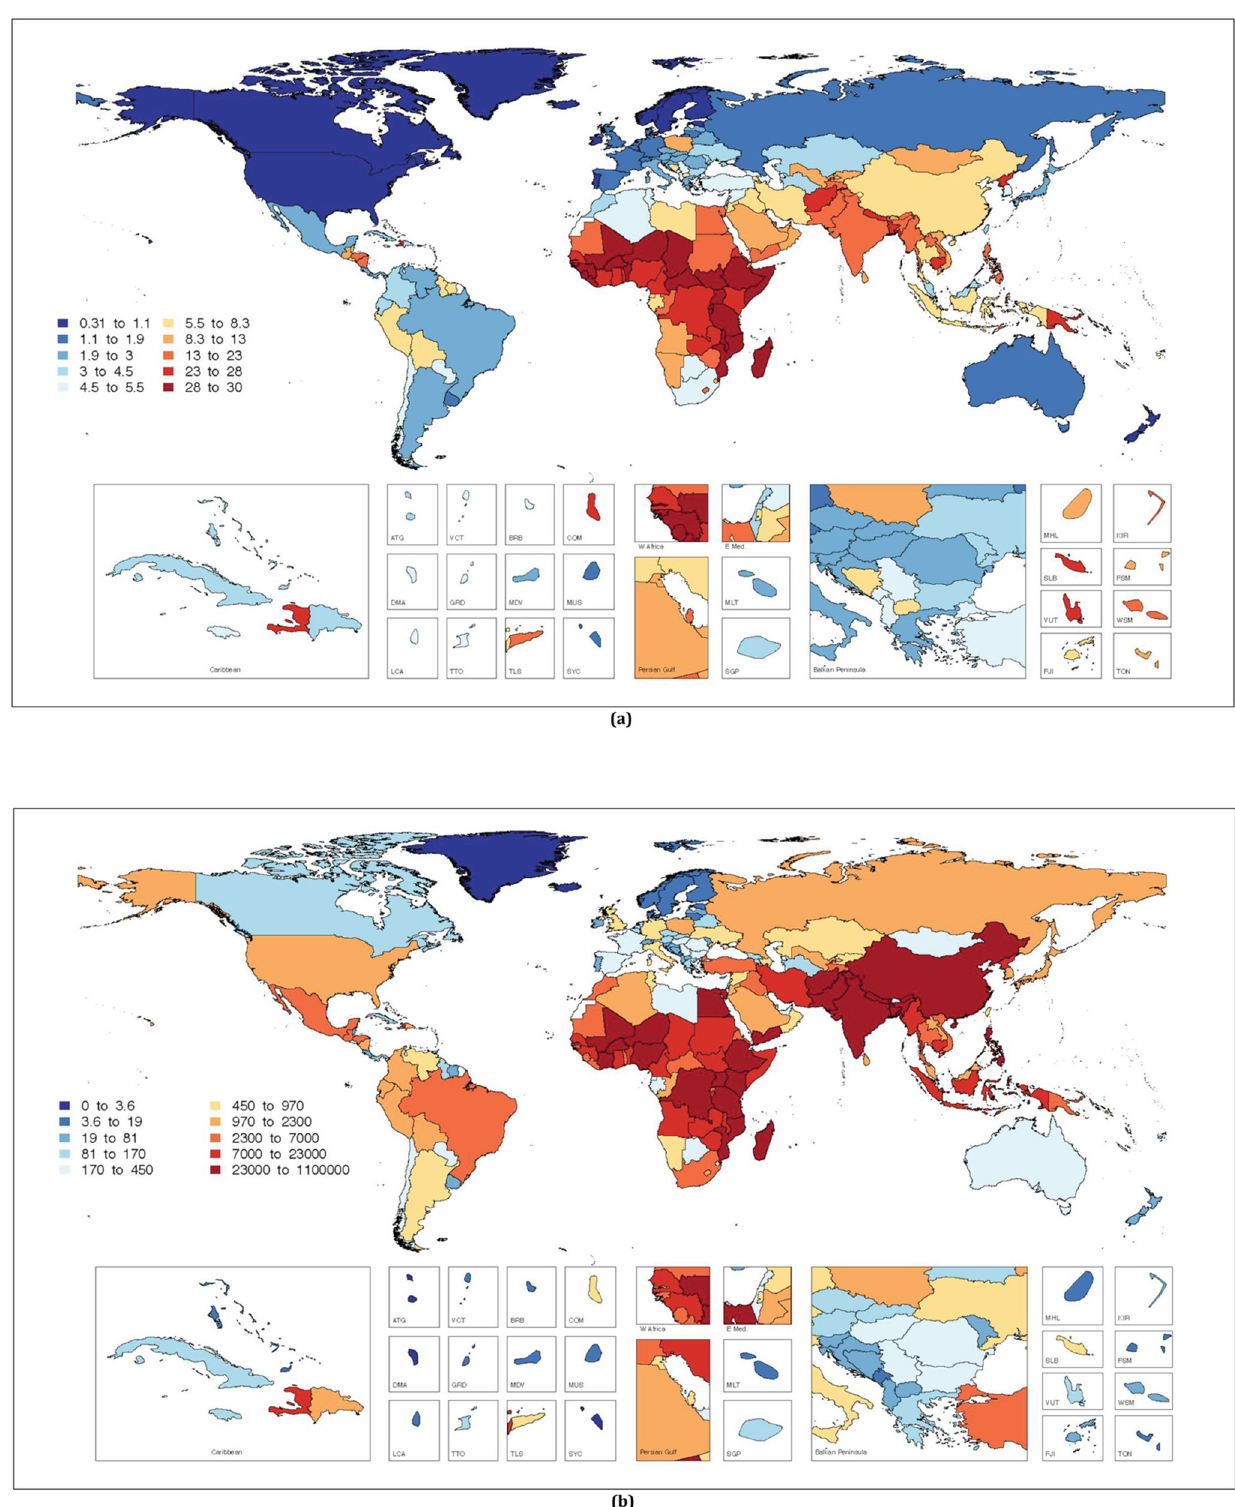
Fig 4. The estimated global burden [PAFs (a) and PANs (b)] of low birth weight attributable to total PM 2.5 air pollution (from ambient and household sources) for 2019. PAF, population attributable fraction; PAN, population attributable number; PM 2.5 , particulate matter < 2.5 micrometer.